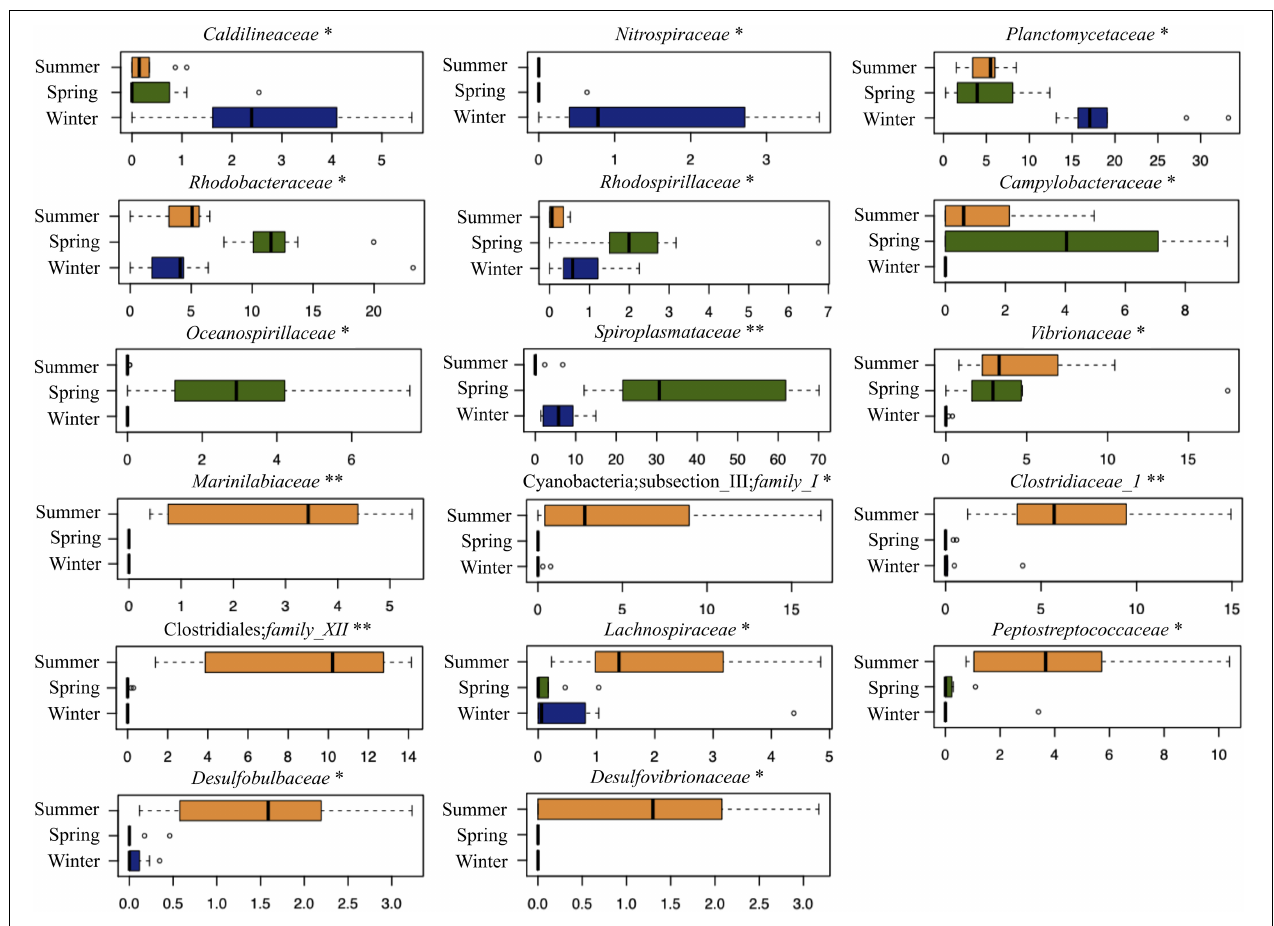
FIGURE 3 | C. viridis -associated bacterial families differently represented across seasons. Box-and-whisker plots showing the relative abundance distribution of bacterial families in the different seasons (winter, dark blue; spring, dark green; and summer, orange). The central box represents the distance between the 25th and 75th percentiles. The median is marked with a black line. Whiskers identify the 10th and 90th percentiles. ∗ p -value ≤ 0.05; ∗∗ p -value ≤ 0.01; Kruskal–Wallis test controlled for multiple testing using FDR.